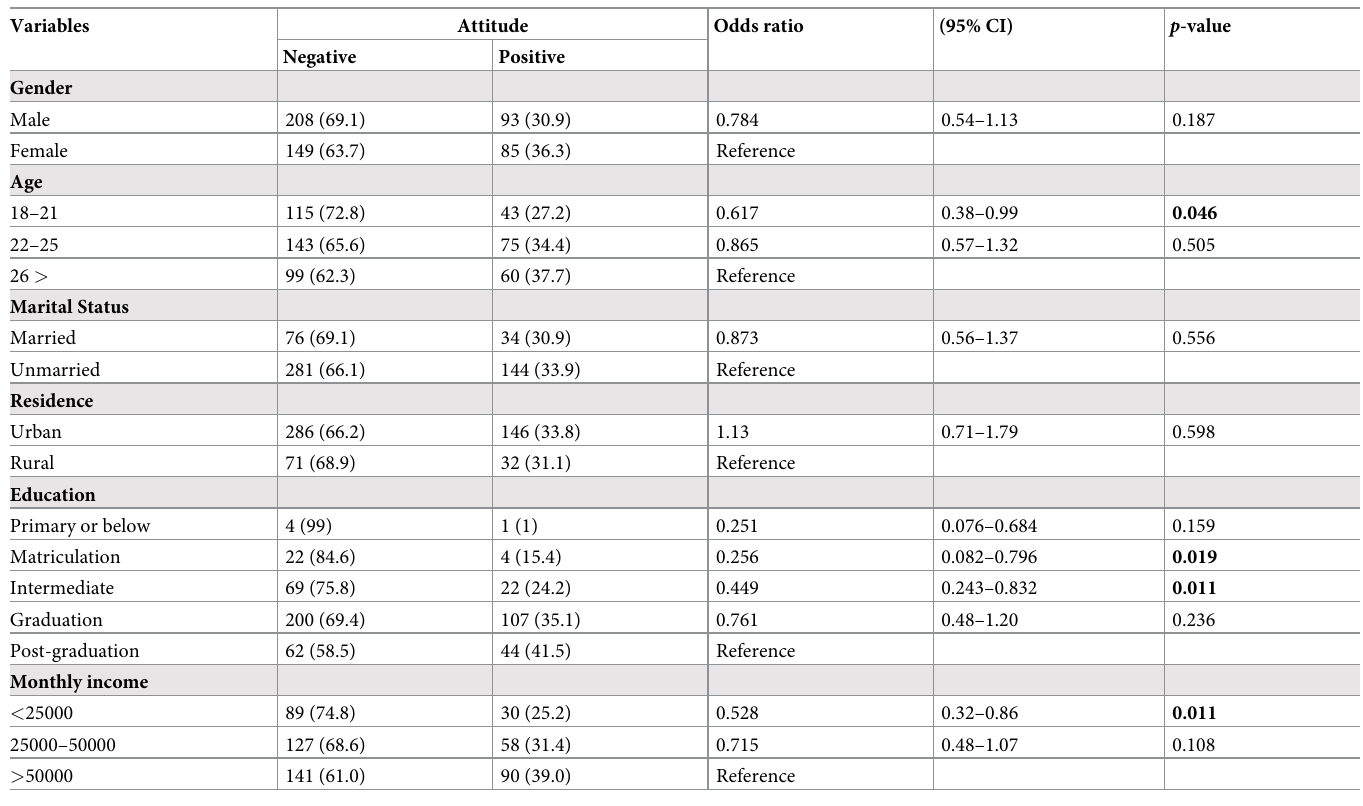
Table 7. Binary logistic regression analysis to find factors of positive attitudes ( N =